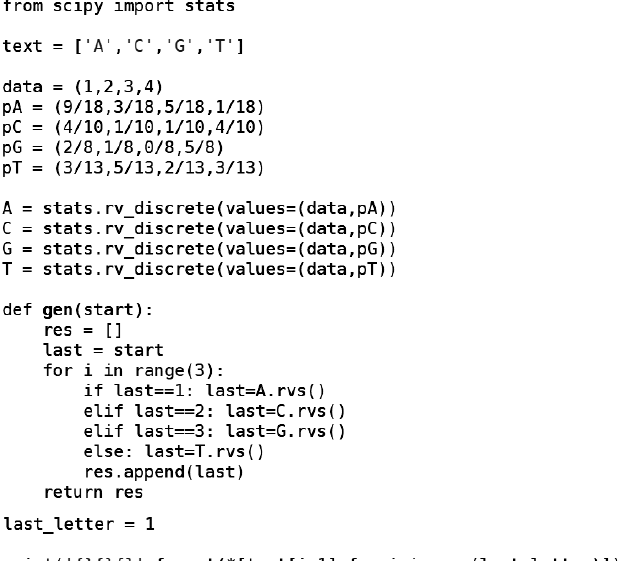
Figure 7. Program executes computations from Example 2 with probabilities from the transition matrix Π 1 and generates the completion of sequence (8) with exactly three